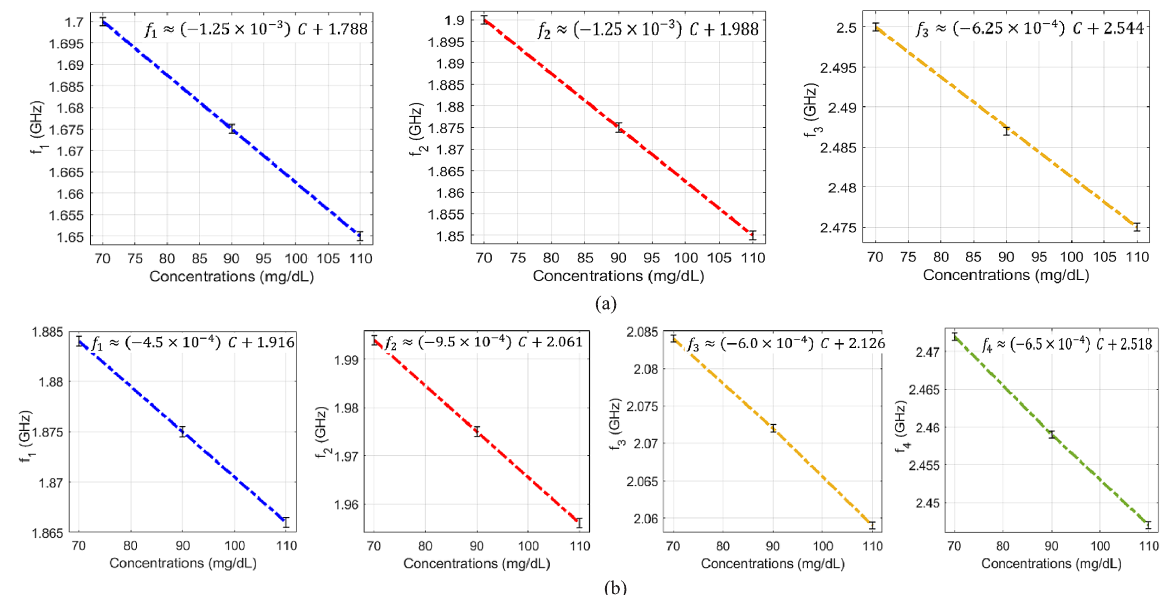
Figure 13. Linear correlation models for the resulting resonant frequencies of ( a ) compact sensor at three frequencies of f 1 (in blue), f 2 (in red), and f 3 (in orange), and ( b ) dispersed sensors at four frequencies of f 1 (in blue), f 2 (in red), f 3 (in orange), and f 4 (in green) at different glucose concentrations. Reprinted with permission from Ref.